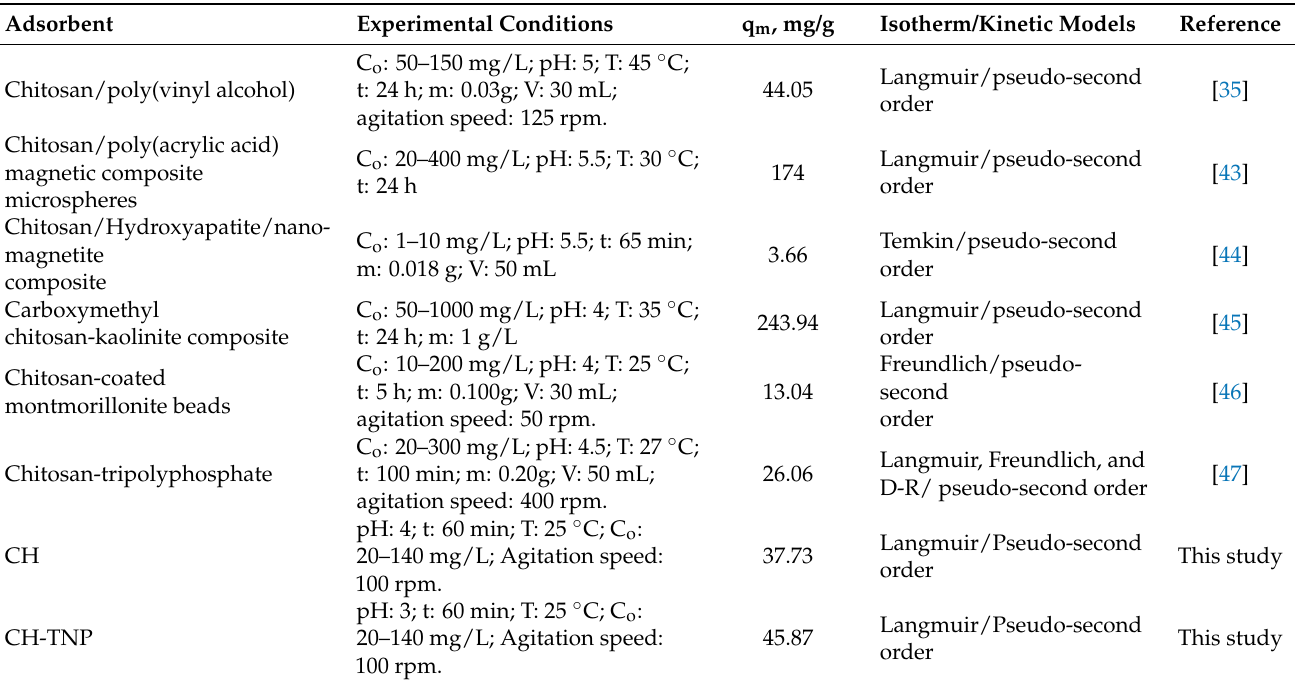
Table 3. Comparison of Cu(II) adsorption on CH-based composite adsorbents. Experimental